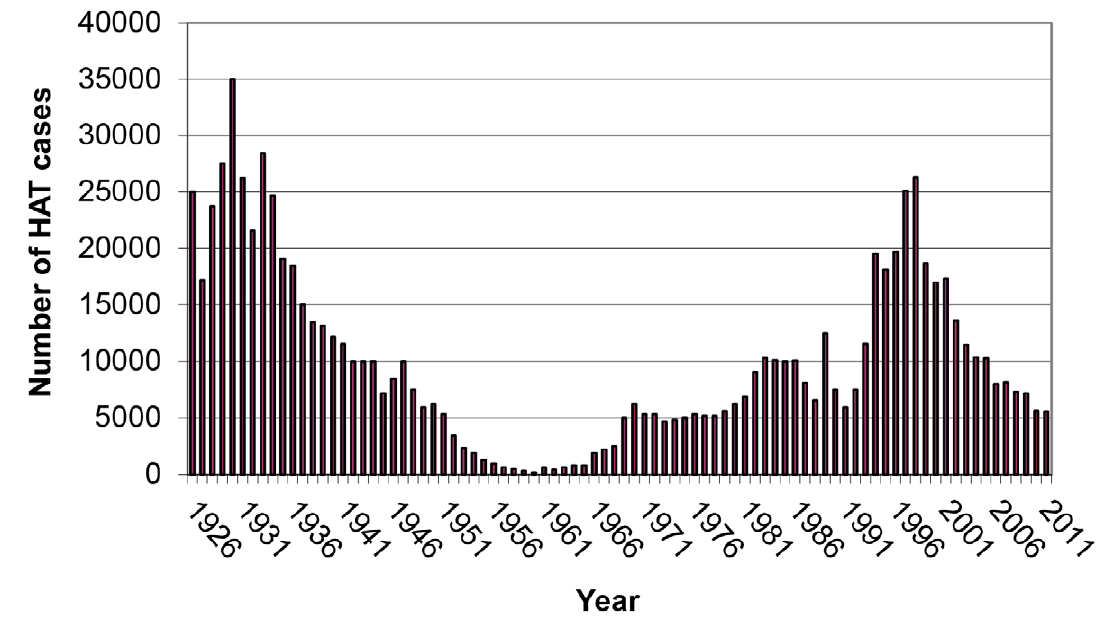
Figure 1. Annual case notification of HAT in DRC, 1926–2011. Source: PNLTHA.